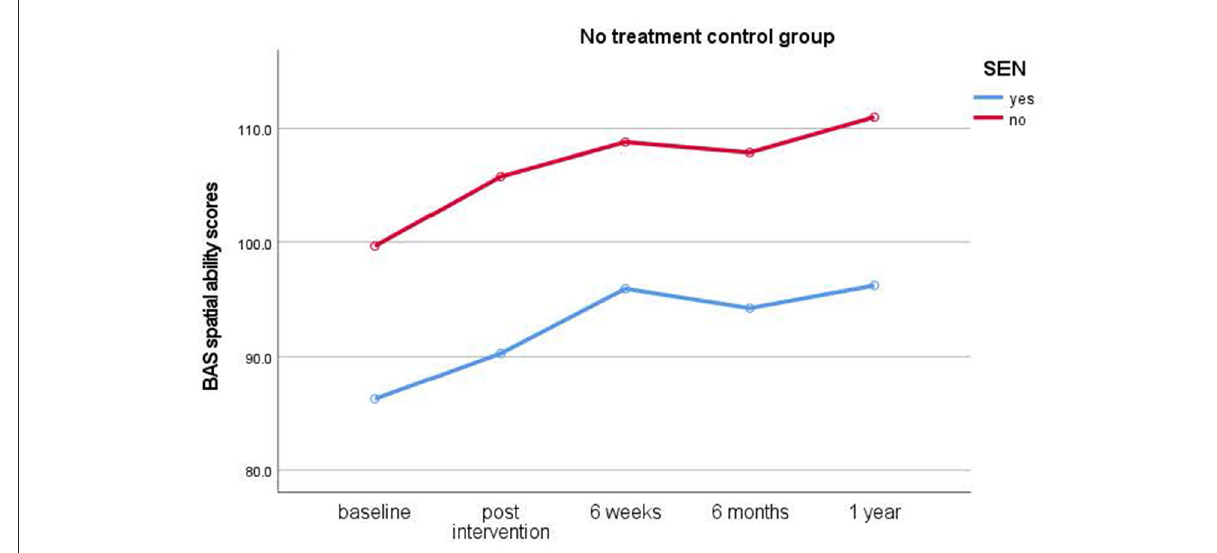
FIGURE4 Results of longitudinal assessments in the no treatment control group: means for British Ability Scale spatial ability scores (y-axis) over time (x-axis) in the no treatment control group for children with and without special educational needs (SEN). Higher scores imply higher